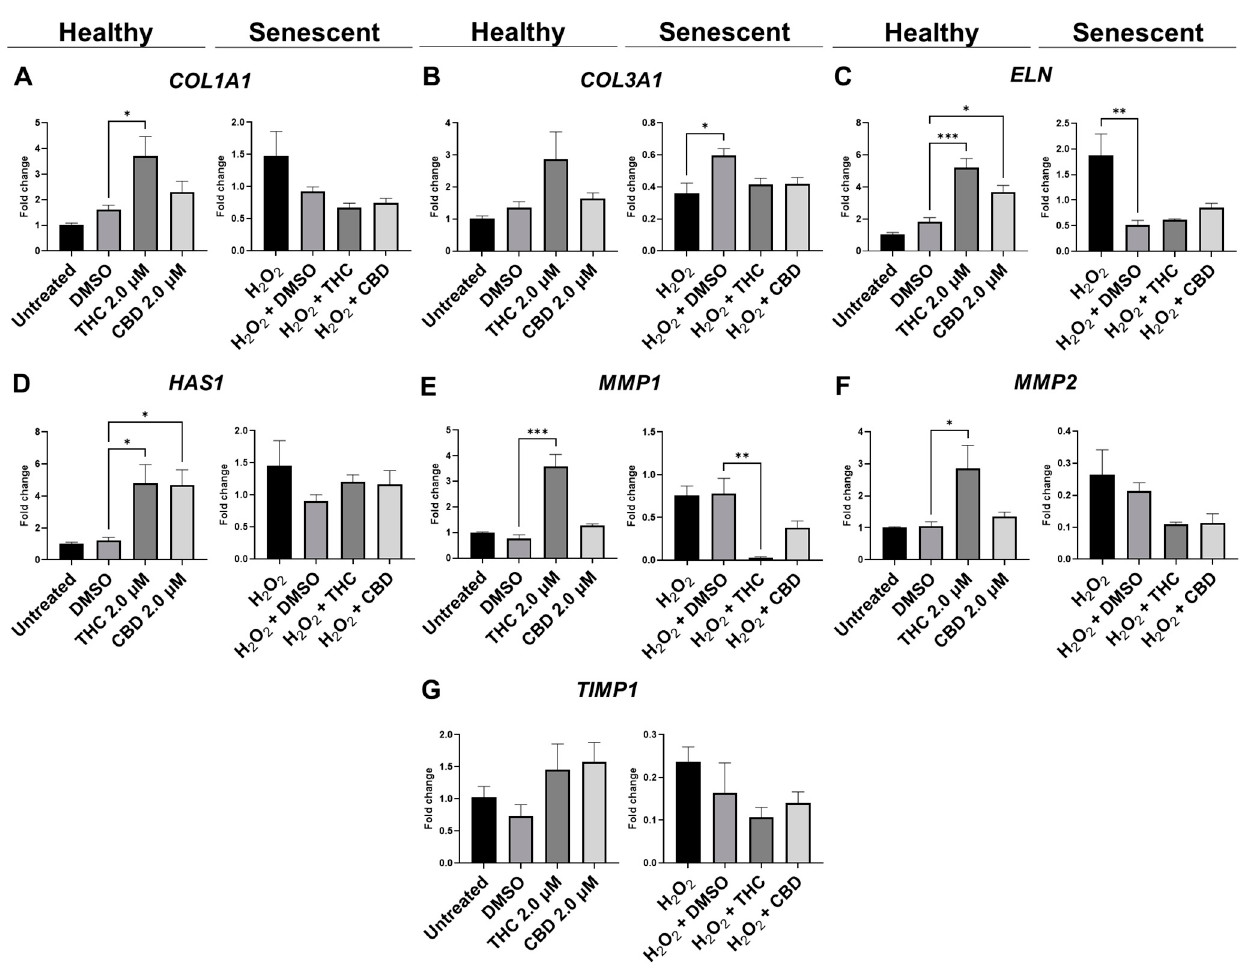
Figure 6. Effects of phytocannabinoids on mRNA levels of genes involved in extracellular matrix maintenance in CCD-1064Sk human dermal fibroblasts. mRNA levels were presented as a ratio of the target gene relative to GAPDH for expression of ( A ) COL1A1 , ( B ) COL3A1 , ( C ) ELN , ( D ) HAS1, ( E ) MMP1 , ( F ) MMP2 , and ( G ) TIMP1 . Data were analyzed with an ANOVA test followed by a Dunnett’s post-hoc multiple comparison test compared to the vehicle. Bars represent mean ± SEM, n = 3. Significance is indicated using the following scale: * p < 0.05, ** p < 0.01, *** p < 0.001.